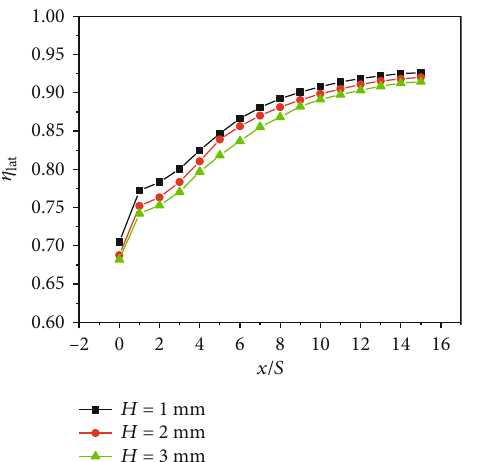
Figure 18: In fl uence of impingement hole diameter on cooling e ffi ciency